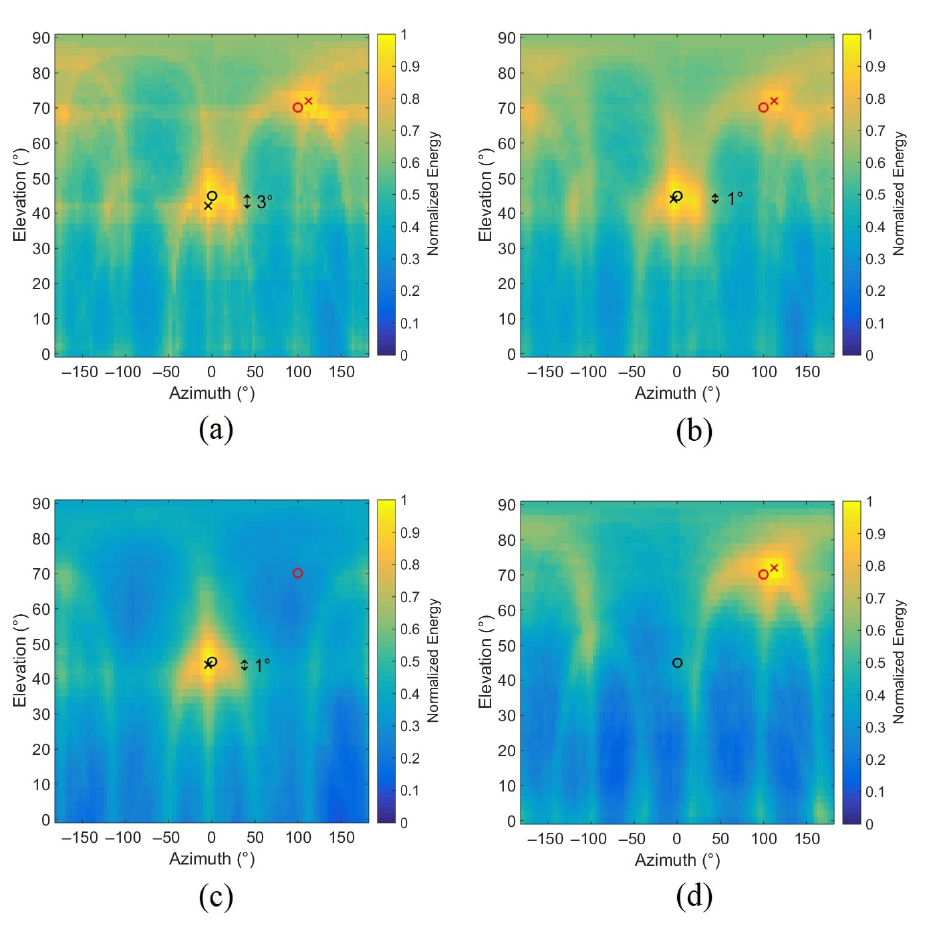
Figure 6. Normalized energy maps in the presence of two sources taking ( a ) the whole energy, ( b ) 5 harmonics of both sources in the TFR, ( c ) 5 harmonics of source 1 ( f 01 = 150 Hz), ( d ) 5 harmonics of source 2 ( f 02 = 175 Hz) (the circles and the crosses represent, respectively, the actual positions of the virtual sources and the positions of the two energy